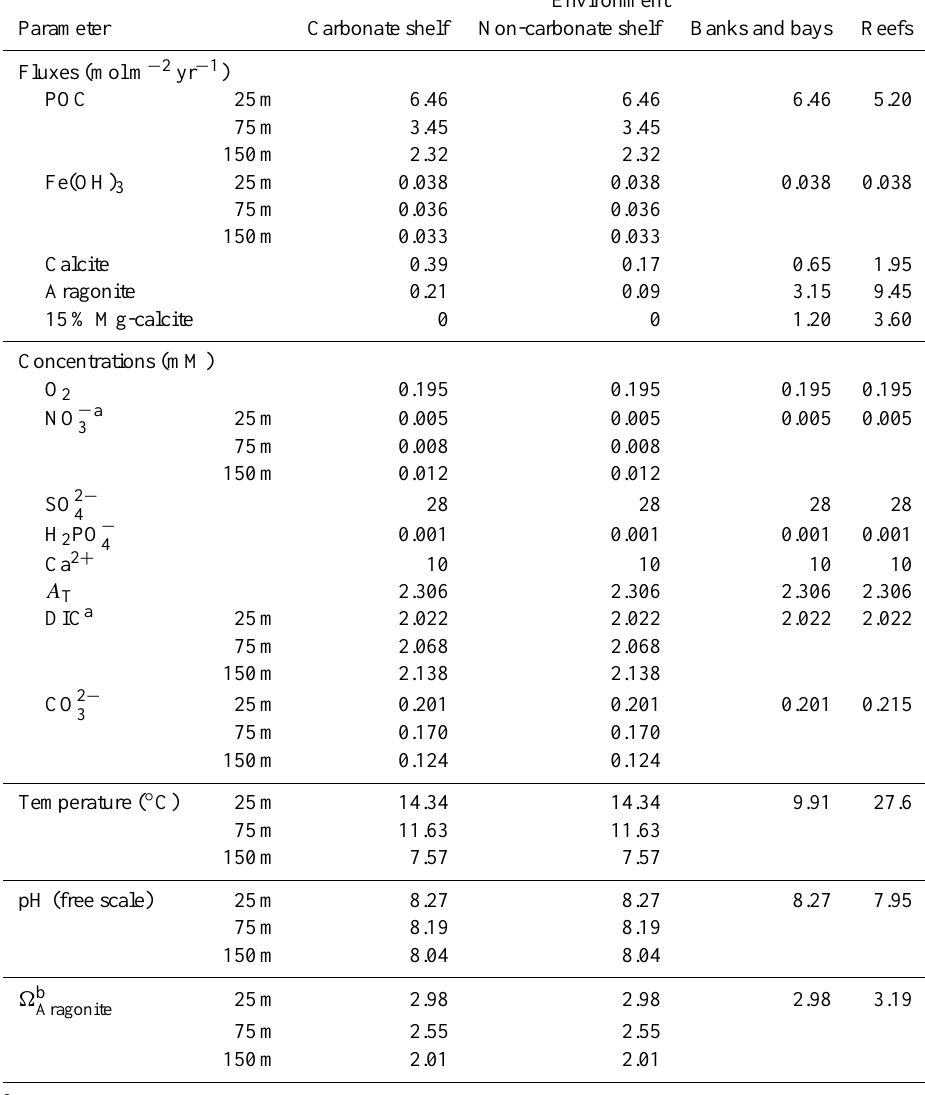
Table 6a. Boundary conditions, baseline